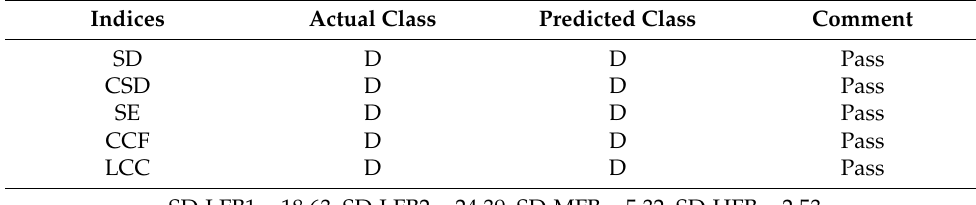
Figure 25. Frequency response of HV winding before and after the fault. Table 3. Performance matrices of ANN for different indicators in assessing case